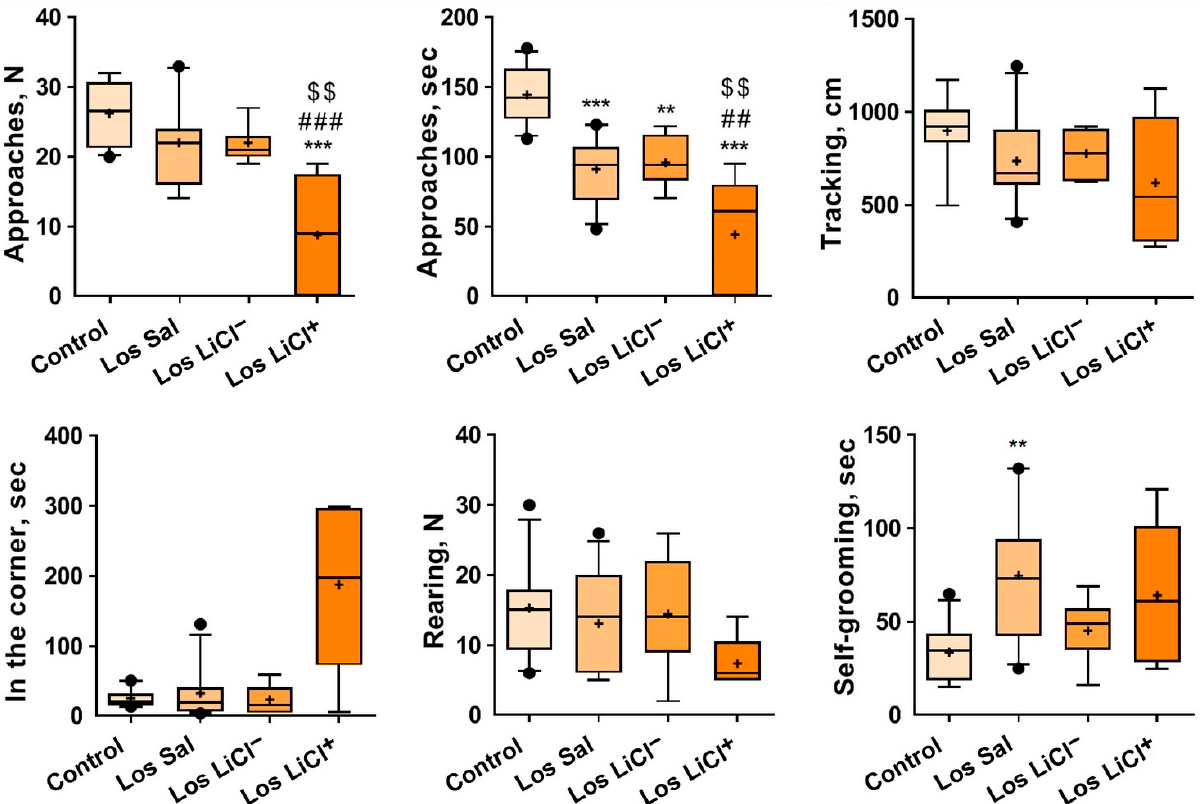
Figure 5. Effects of LiCl on the behavior of defeated mice in the social interaction test as a reaction to the partner under the pencil holder. Note: Control ( n = 9); Los Sal - Sal-treated losers ( n = 11); Los LiCl − - LiCl − - treated losers ( n = 7); Los LiCl + - LiCl + -treated losers ( n = 5). The data are shown as means (plus sign), medians (solid lines), and 25%/75% quartiles in the box-whisker plot, with whiskers indicating the 10th and 90th percentiles. ** p < 0.01, *** p < 0.001 vs. controls; ## p < 0.01, and ### p < 0.001 vs . Sal-treated losers; $$ p < 0.01 vs. LiCl − - treated losers.